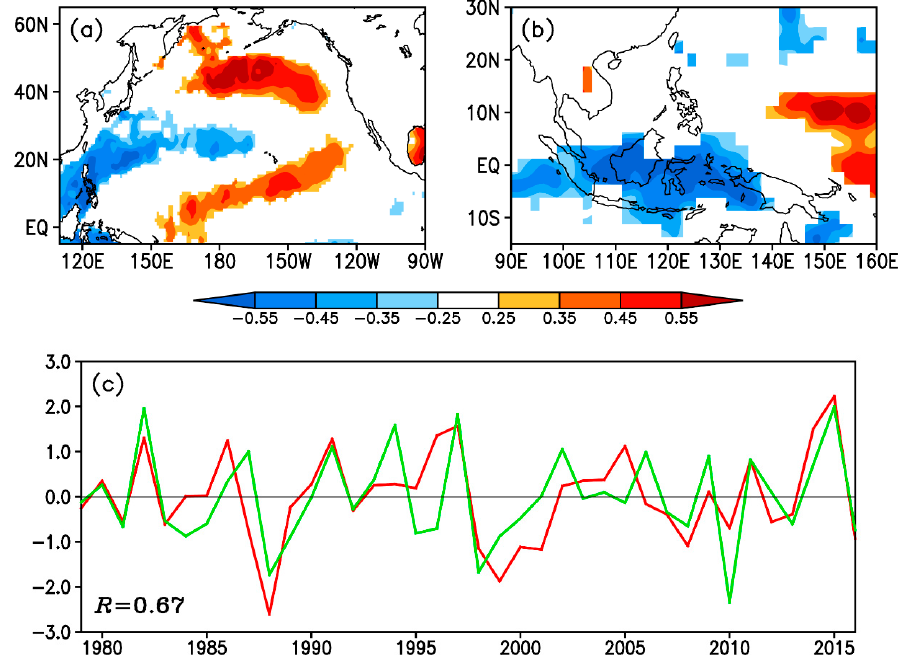
Figure 4. Spatial properties of the leading singular value decomposition (SVD) mode for ( a ) the FMA SST anomalies in the North Pacific (20° N–65° N, 125° E–100° W) and ( b ) the following JAS precipitation anomalies in the SCS (South China Sea) monsoon region (0°–22° N, 110° E–120° E), shown as correlation maps of the respective heterogeneous SST and precipitation fields with the SVD leading normalized expansion coefficients. Areas with the correlation coefficients significant at the 90% confidence level are shaded. ( c ) The SVD leading normalized expansion coefficients of the FMA SST field (red line) and the following JAS precipitation field (green line).